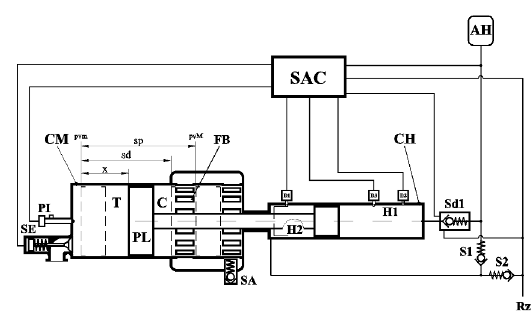
Figure 3. The scheme of the uniflow scavenge two strokes thermo- generator